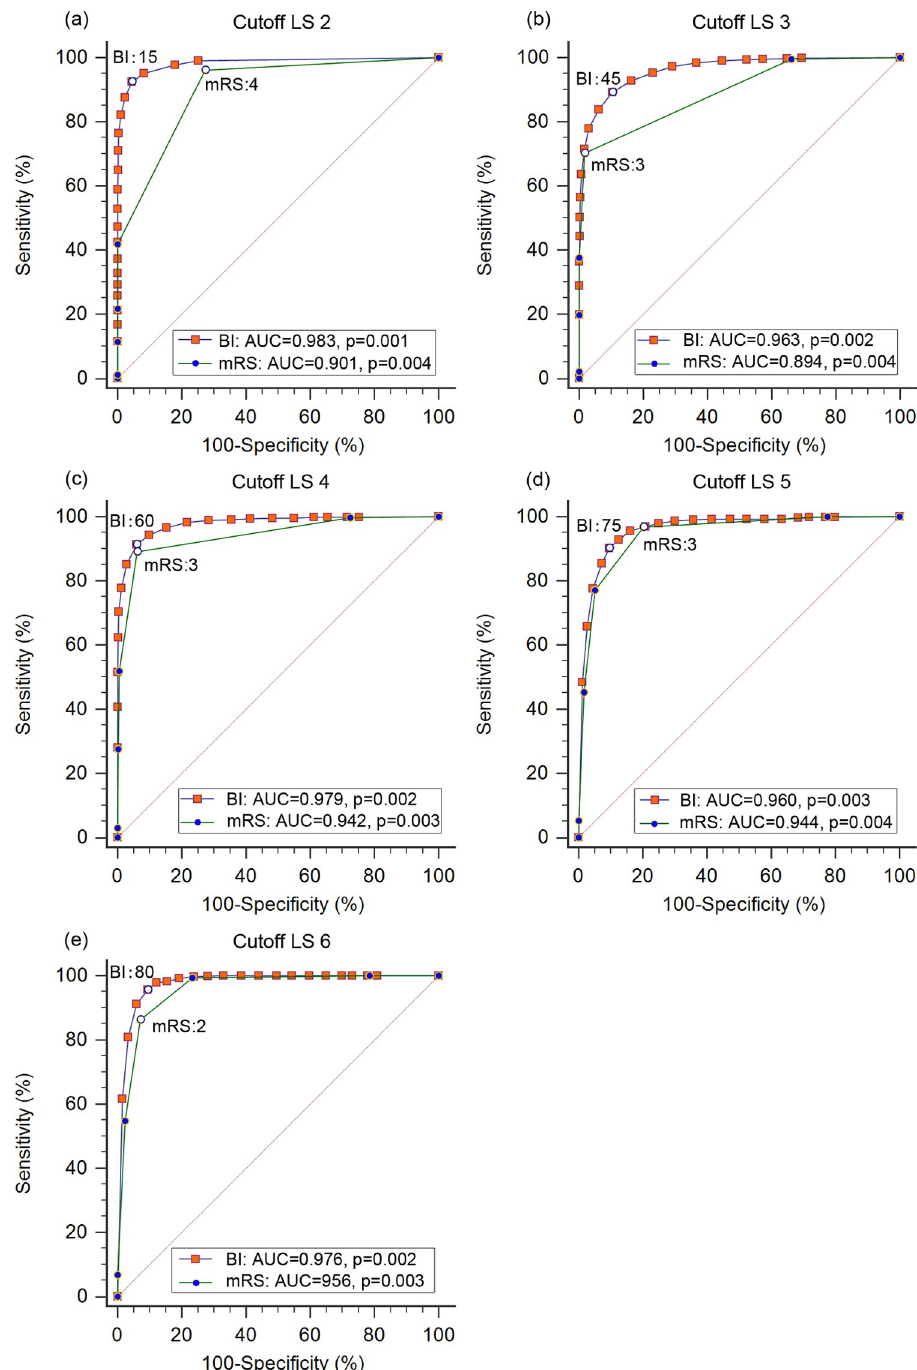
Fig 3. ROC curves for adjusted mRS and BI cutoff scores in LS grades 2, 3, 4, 5 and 6. LS: Longshi Scale; mRS: modified Rankin scale; BI: Barthel Index; ROC: Receiver Operating Characteristic; AUC: Area Under Curve. (a) ROC curves for adjusted mRS and BI cutoff scores in LS 2. sensitivity:96.12%, 92.54%; specificity:72.72%, 95.48%, 95.48%; AUC: 0.901, 0.983; respectively; (b) ROC curves for mRS and BI cutoff scores in LS 3. sensitivity:70.24%, 89.28%; specificity:98.29%, 89.51%; AUC: 0.894, 0.963; respectively; (c) ROC curves for mRS and BI cutoff scores in LS 4. sensitivity:89.10%, 91.32%; specificity:93.81%, 94.02%; AUC: 0.942, 0.979; respectively; (d) ROC curves for mRS and BI cutoff scores in LS 5. sensitivity:96.80%, 90.30%; specificity:79.82%, 90.41%; AUC: 0.944; 0.960; respectively; (e) ROC curves for mRS and BI cutoff scores in LS 6. sensitivity:86.23%, 95.65%; specificity:92.89%, 90.62%; AUC: 0.956; 0.976;